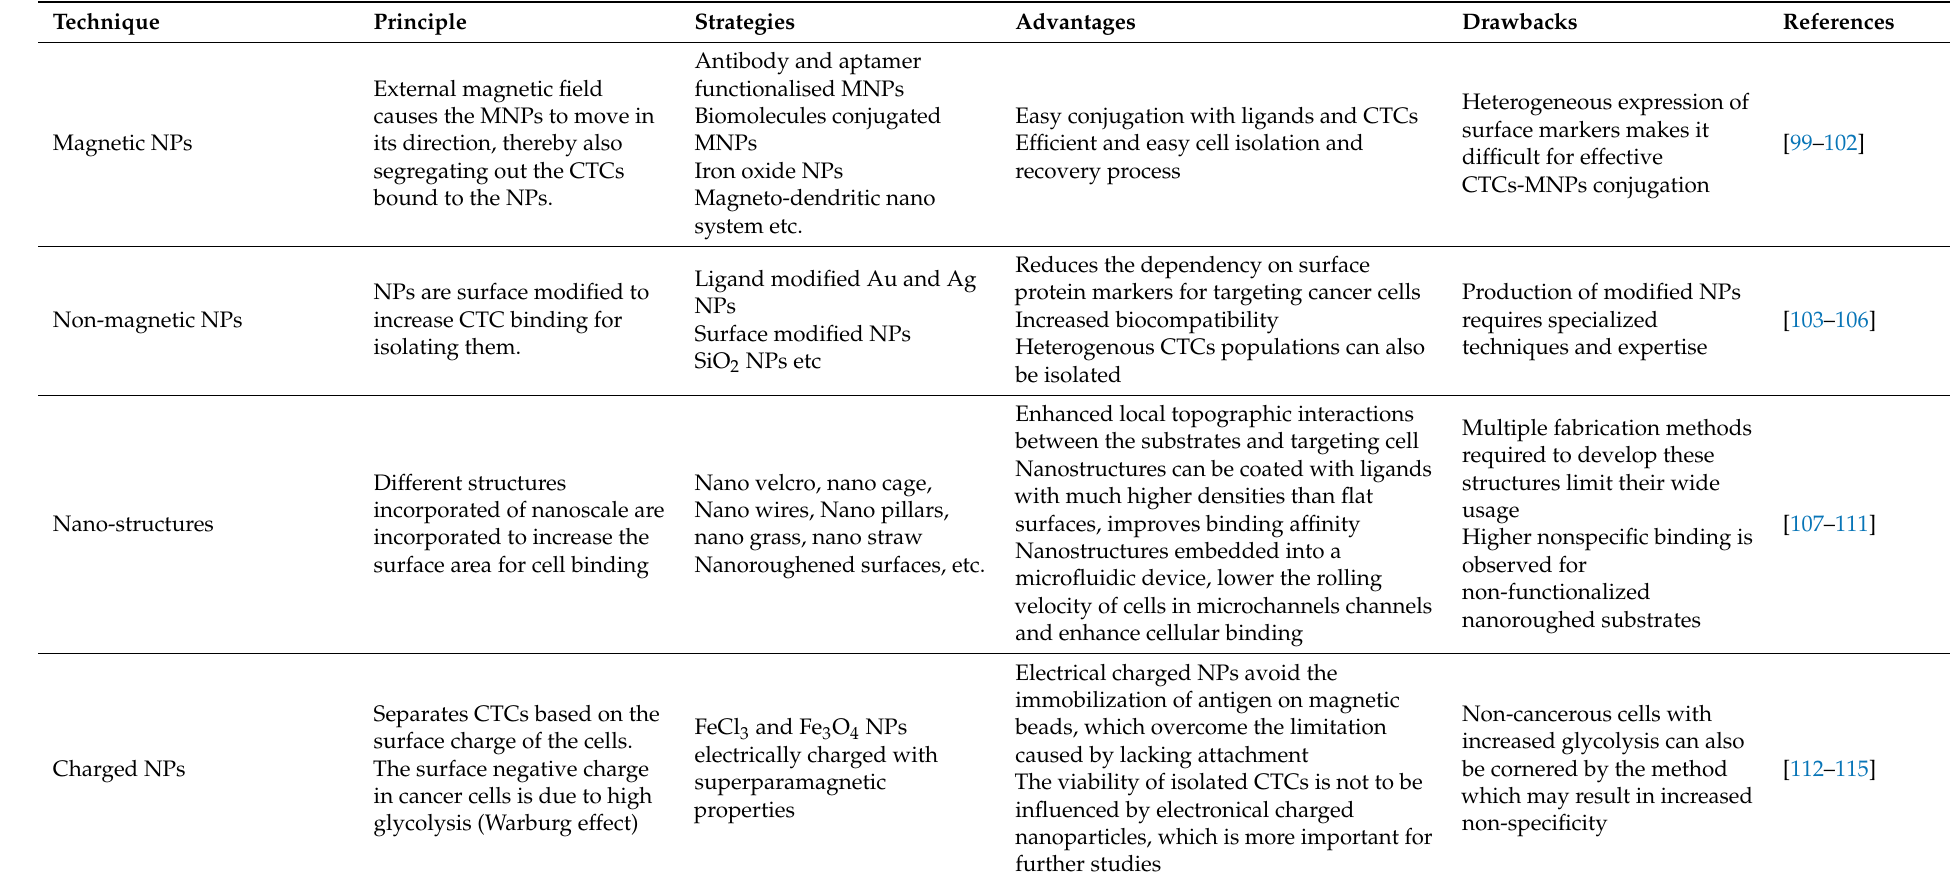
Table 2. Different techniques used in the isolation of